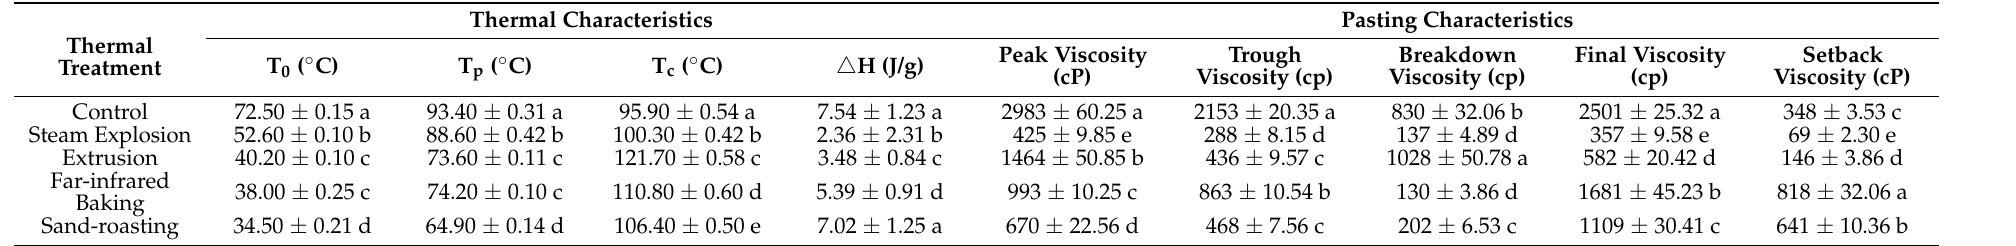
Table 2. Thermal and pasting characteristics of whole grain highland barley flour with different thermal